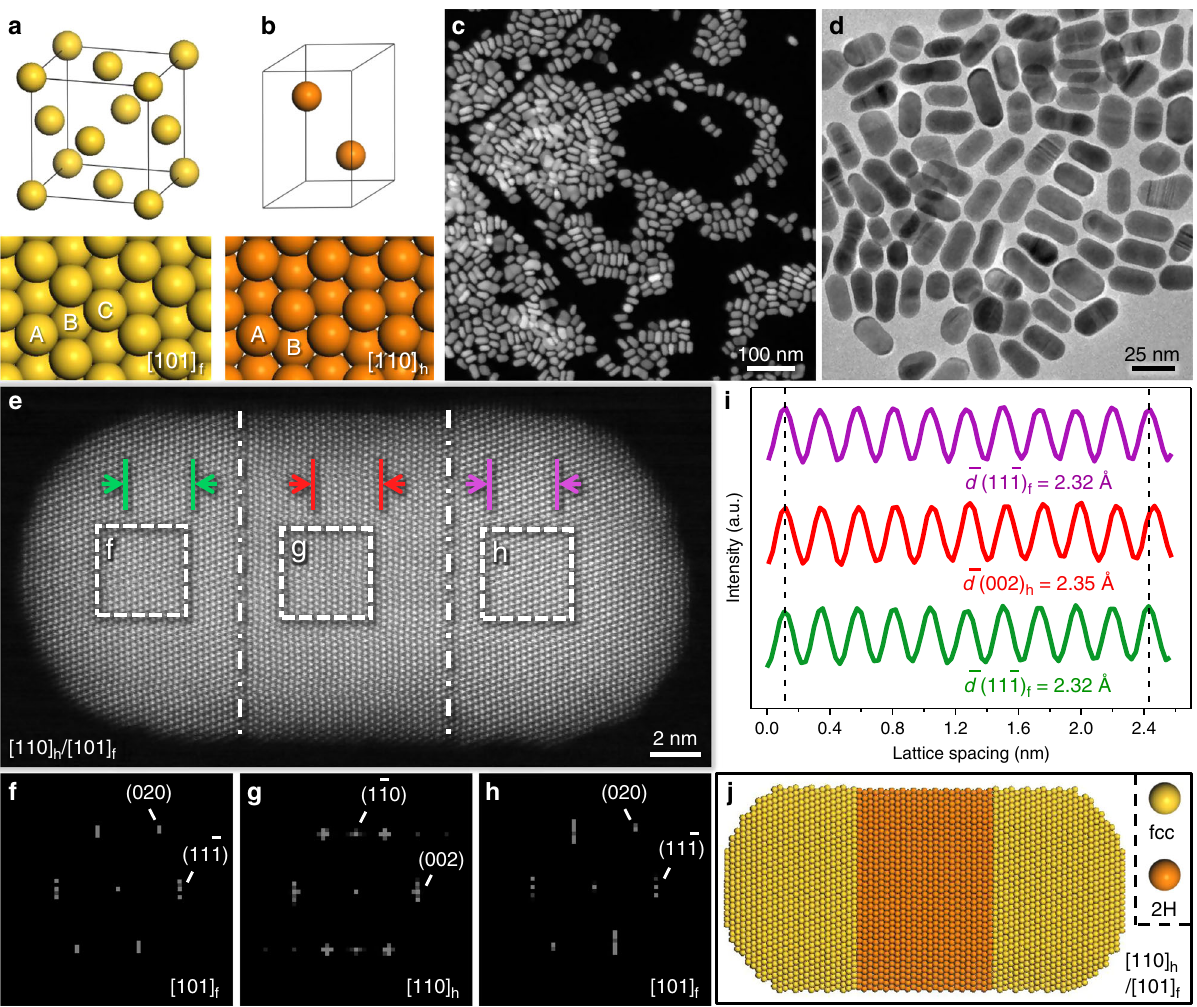
Fig. 1 Synthesis and structural characterization of well-de fi ned heterophase fcc-2H-fcc gold nanorods. a Schematic illustration of a unit cell (top panel) and (101) f plane (bottom panel) for the conventional fcc phase. b Schematic illustration of a unit cell (top panel) and (110) h plane (bottom panel) of the unusual 2H phase. c , d Low-magni fi cation HAADF-STEM ( c ) and high-magni fi cation TEM ( d ) images of Au NRs. e A representative aberration-corrected high-resolution HAADF-STEM image of an Au NR. The fcc/2H phase boundaries are marked with white dashed-dotted lines. f – h FFT patterns of the corresponding selected areas from the two ends ( f , h ) and middle ( g ) of the Au NR shown in e . i The integrated pixel intensities along the arrow directions of the corresponding selected areas in the two ends (green and purple curves) and middle (red curve) of the Au NR shown in e . The peaks and valleys stand for the alternating atoms and spaces, respectively. j An atomic model of the obtained heterophase fcc-2H-fcc Au NRs, viewed along the [110] h /[101] f zone